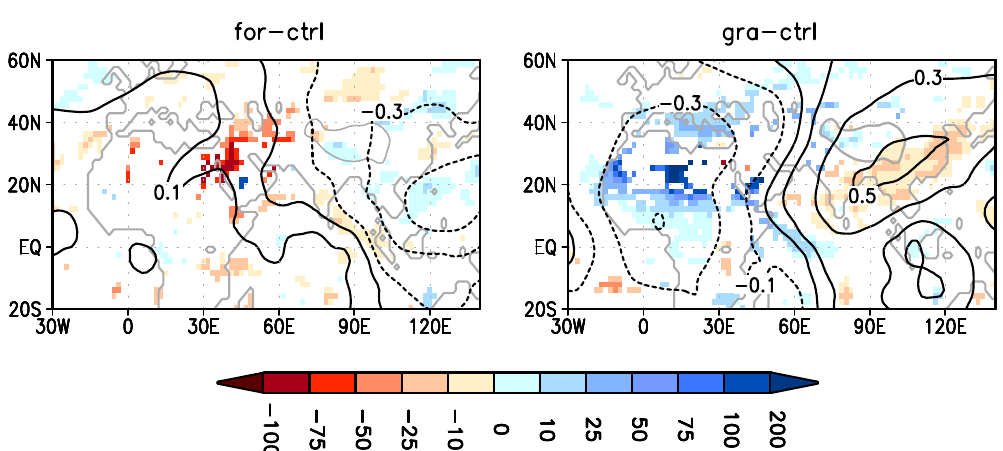
Fig. 13. Simulated change in monsoon season precipitation weighted by the precipitation of the control run in % (shaded) and simulated change in upper-tropospheric velocity potential in km 2 s − 1 (contour). Left panel: afforestation experiment (for) – control run (ctrl); right panel: deforestation experiment (gra) – control run (ctrl). Values are averaged over the monsoon season. Precipitation differences are only shown if they exceed the 95%-significance level in a standard student’s